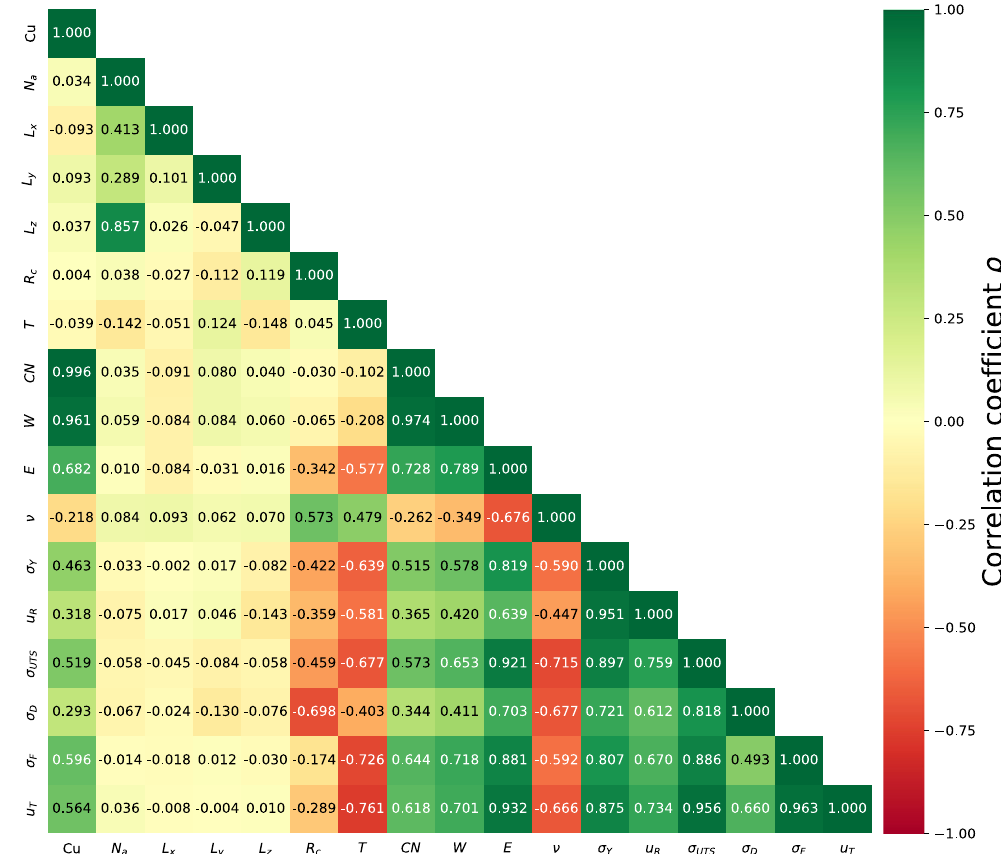
Figure 3. Spearman’s correlation heatmap for all variables. Red color represents negative correlations and green corresponds to positive